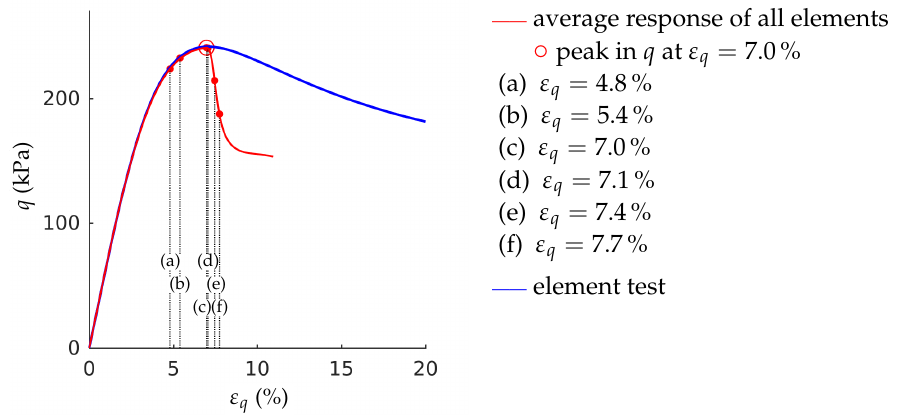
Figure 13. OCR = 54: The deviatoric strain ε q marked with ( a – f ) corresponds to Figure 9a–f. After the peak, the average response of the fine-meshed test shows a pronounced decrease in deviatoric stress compared to the single element test. The pronounced decrease results from the varying stress-strain curves in the individual elements, during softening, see Figures 14a–17a. The stress-strain curves that are close to the element test are inside the shear band. The stress-strain curves that are similar to unloading curves are outside the final shear band, see also Figure 4c and [22]. The average response shows a typical stress-strain curve of a biaxial test (e.g., [33]). Figures 14b–17b show the volumetric behaviour. Again the average response differs from the single element